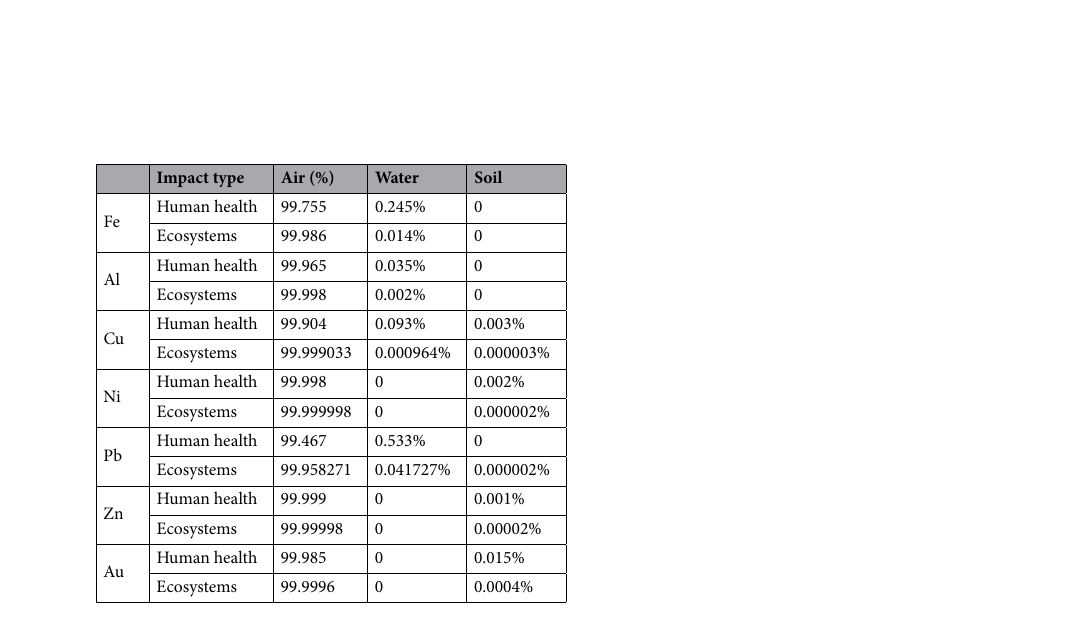
Table 5. Percentage contribution of emissions to air, water and soil on human health and ecosystem endpoint